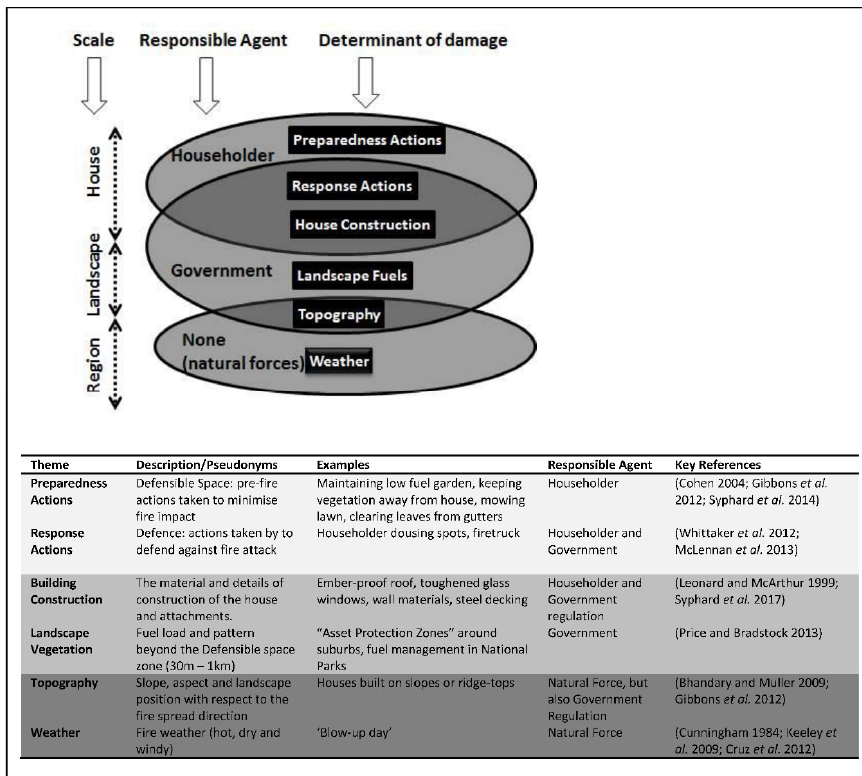
Figure 1. A conceptual model of the main determinants of house impact (called themes in the text), the agent responsible for mitigation and the scale at which they operate. The table provides a description, some examples of each determinant and key references.